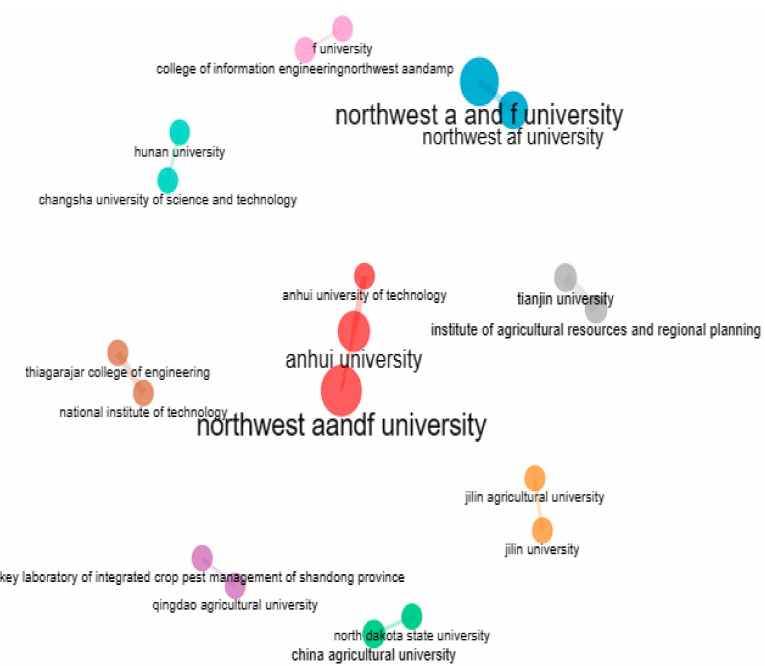
Figure 29. Structure of Co-authorship relationships between Institute (Source: Author elaboration using Biblioshiny).